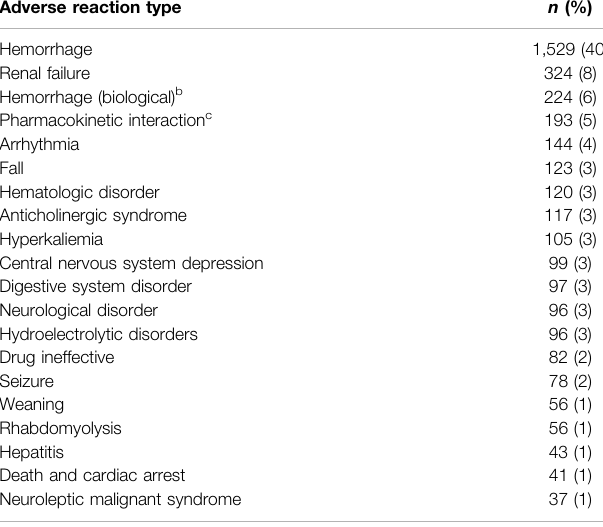
TABLE 5 | ADR 20 most frequent types among serious cases, n (cid:1) 3,843 a . Adverse reaction type Hemorrhage